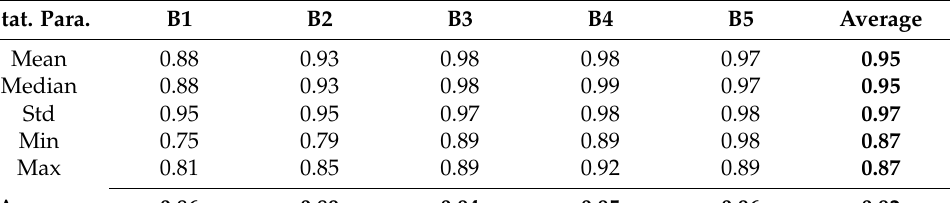
Table 1. Correlation coefficients between the statistical parameters of unnormalized R rs and R rs_TOA for the 24 water bodies at five Landsat-8 bands and the averages for all five bands and five parameters. The p -values of their correlations, with the orders of 10 − 12 to 10 − 14 , are much smaller than 0.05. Stat. Para.